Question: Briefly state, in one sentence, what is plotted here.
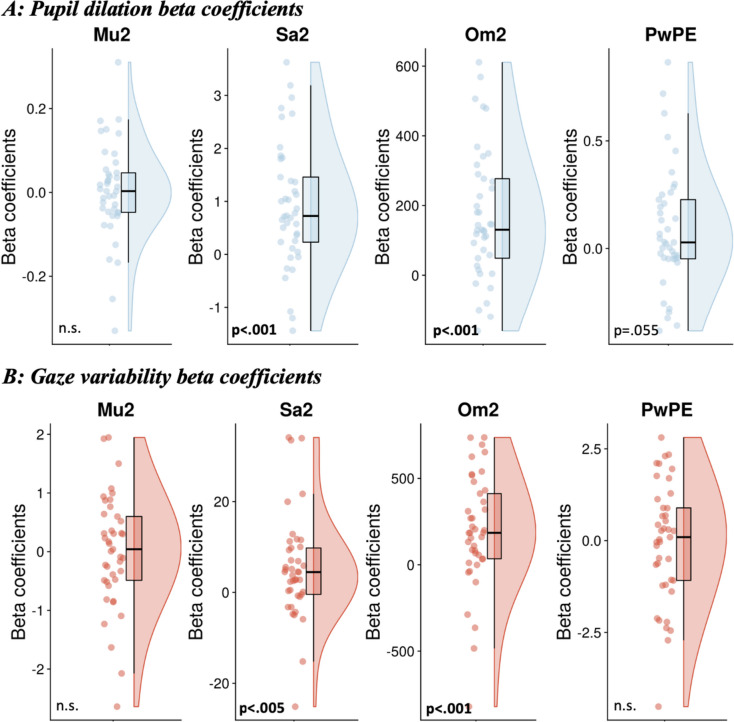
Answer: Beta coefficients for relationships of model parameters with gaze variability and pupil dilations. Note: Raincloud plots of the beta coefficients from the participant-wise robust regressions for beliefs (Mu2), precision of beliefs (Sa2), variance of the random walk in beliefs (Om2), and precision-weighted prediction errors (PwPE) shown for pupil dilation ( A , top) and gaze variability ( B , bottom)